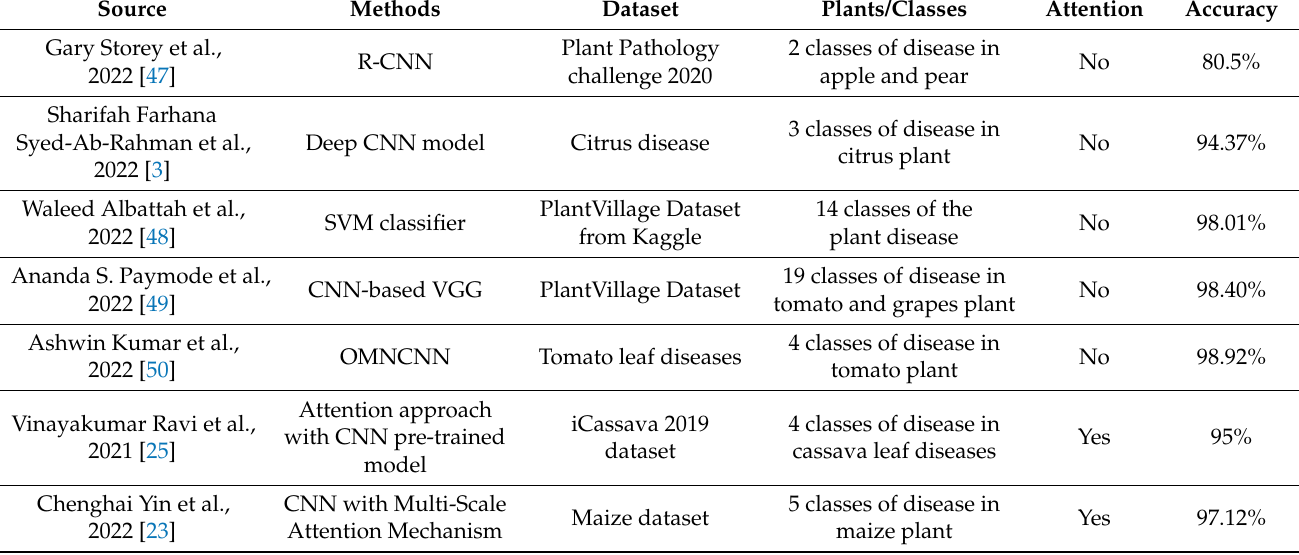
Table 10. Comparison study with the existing